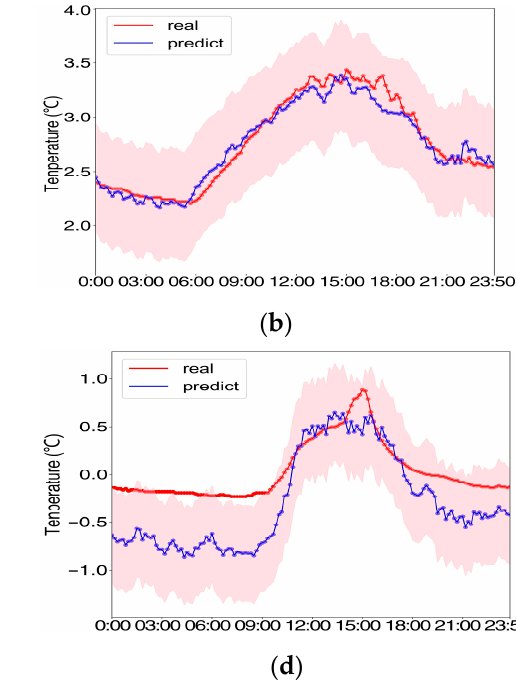
Figure 6. High and low temperature weather forecast effect. High temperature: ( a ) BP neural network, ( b ) stepwise regression. Low temperature: ( c ) BP neural network, ( d ) stepwise regression (the red area in the figure: prediction temperature ± 0.5 °C by the model).